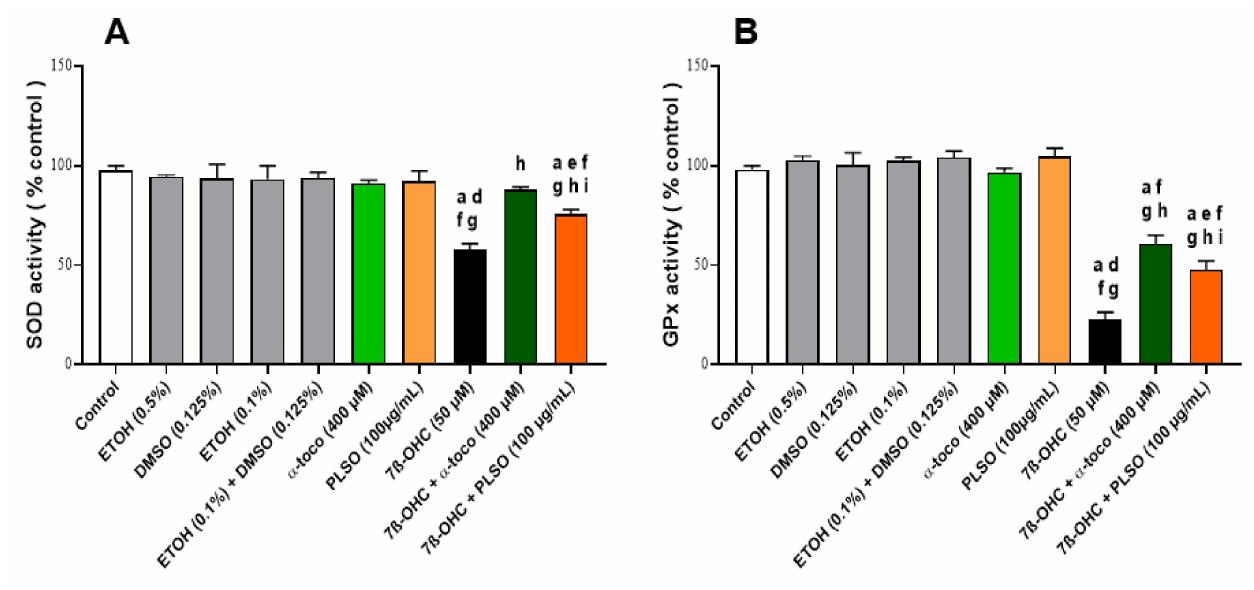
Figure 3. Effect of Pistacia lentiscus L. seed oil (PLSO) and 7 β -hydroxycholesterol on antioxidant enzyme activities (SOD, GPx) in C2C12 cells . C2C12 cells were incubated for 24 h with or without 7 β -OHC (50 µ M) in the presence or absence of PLSO (100 µ g/mL) or α -tocopherol (400 µ M). The measurement of superoxide dismutase (SOD) activity ( A ) and glutathione peroxidase (GPx) activity ( B ) were realized. Data are presented as the mean ± SD of two independent experiments performed in triplicate. A multiple comparative analysis between the groups, taking into account the interactions, was carried out using an ANOVA test followed by a Tukey’s test. A p -value less than 0.05 was considered statistically significant. The statistically significant differences between the groups, which are indicated by different letters, take into account the vehicle used. a: comparison versus control; b: comparison versus ETOH (0.5%); c: comparison versus DMSO (0.125%); d: comparison versus ETOH (0.1%); e: comparison versus (ETOH (0.1%) + DMSO (0.125%)); f: comparison versus α -toco (400 µ M); g: comparison versus PLSO (100 µ g/mL); h: comparison versus 7 β -OHC (50 µ M); i: comparison versus 7 β -OHC (50 µ M) + α -toco (400 µ M). No significant differences were observed between the untreated (control) and vehicle-treated